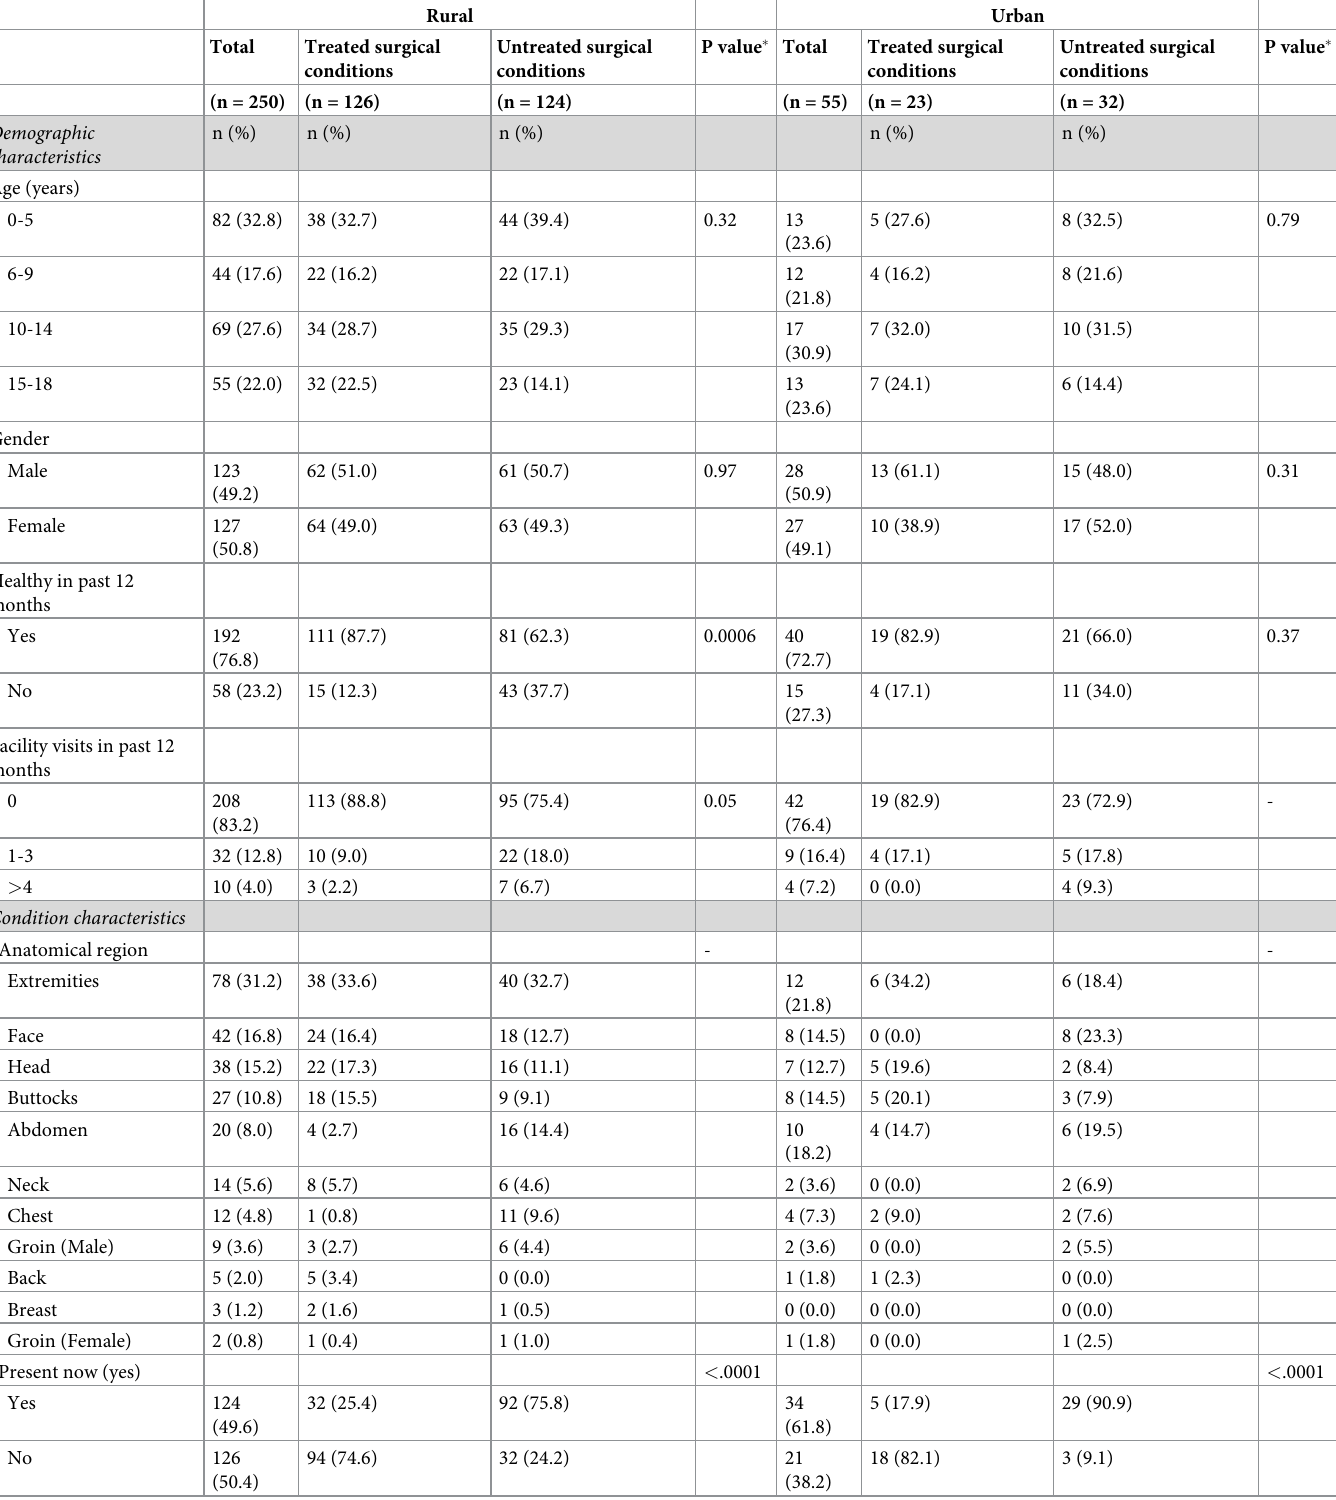
Table 2. Demographic characteristics and condition characteristics of children interviewed in SOSAS, stratified by urban/rural village type and treatment